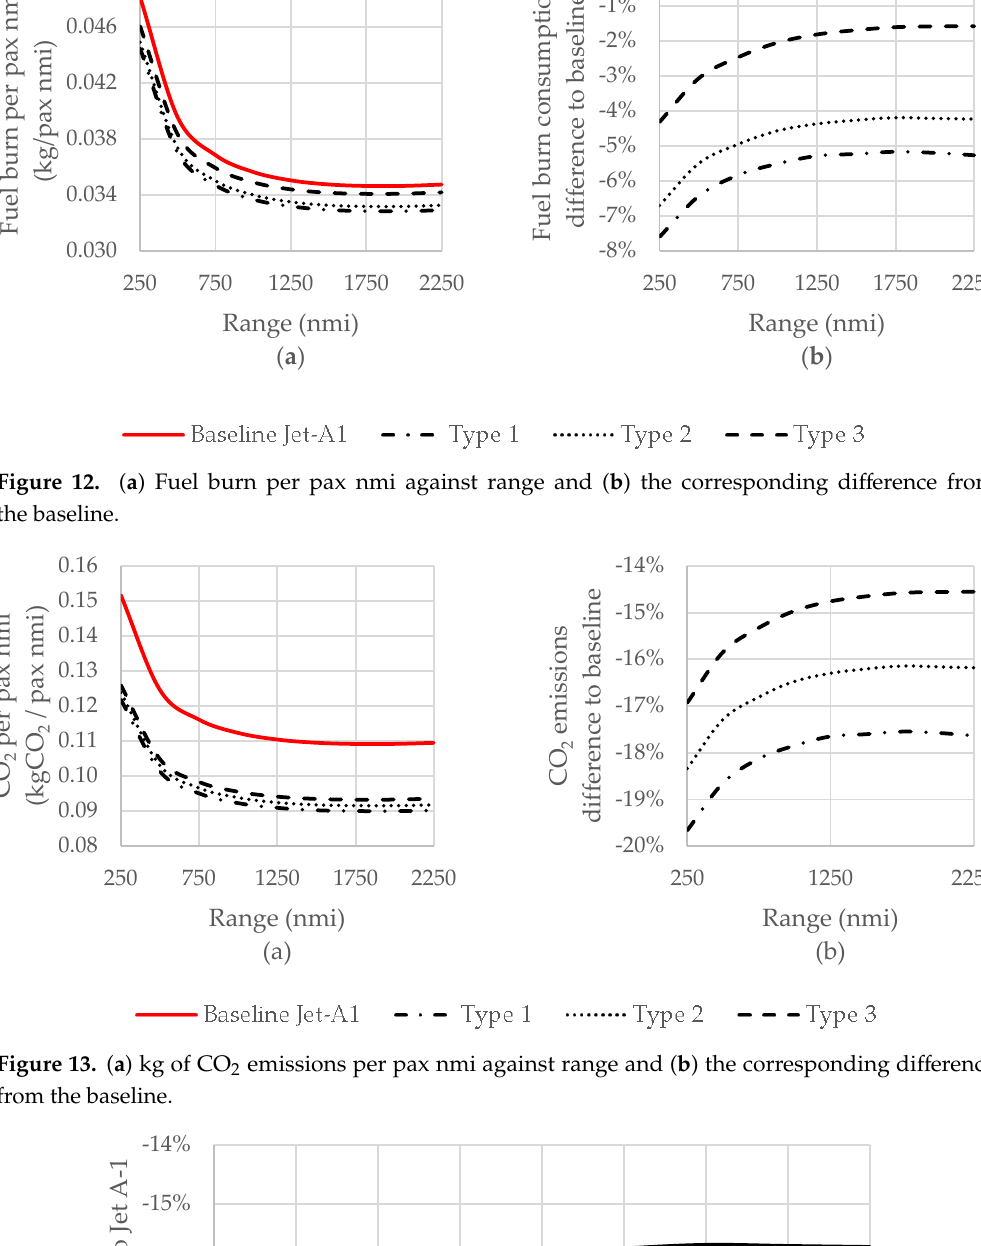
Figure 11. ( a ) Energy per pax nmi against range and ( b ) corresponding difference from the baseline.